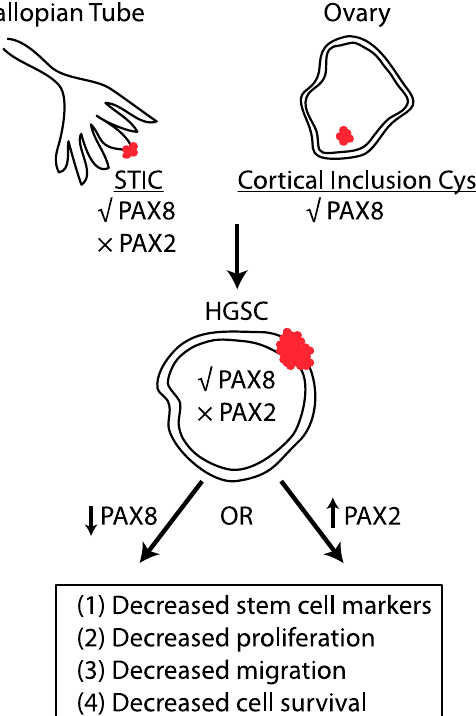
Figure 1. PAX2 and PAX8 regulate tumor formation in HGSC in an opposing manner. Serous tubal